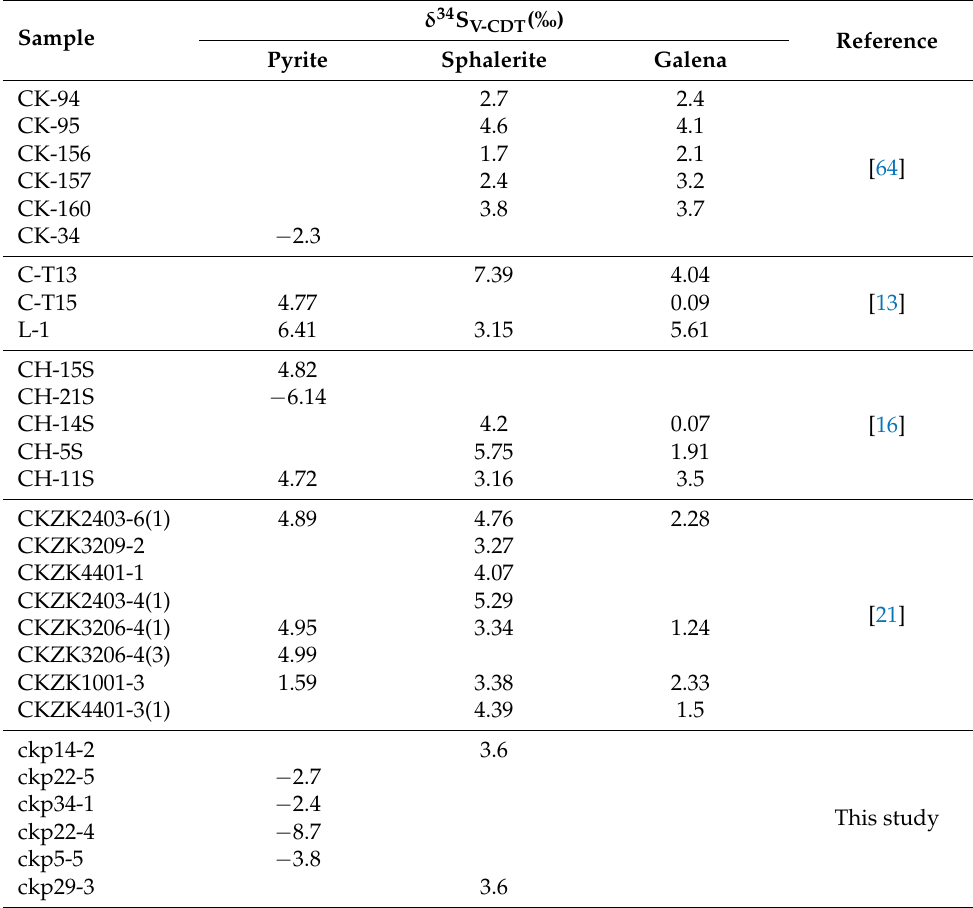
Table 4. S isotope data of the sulfides from the silver